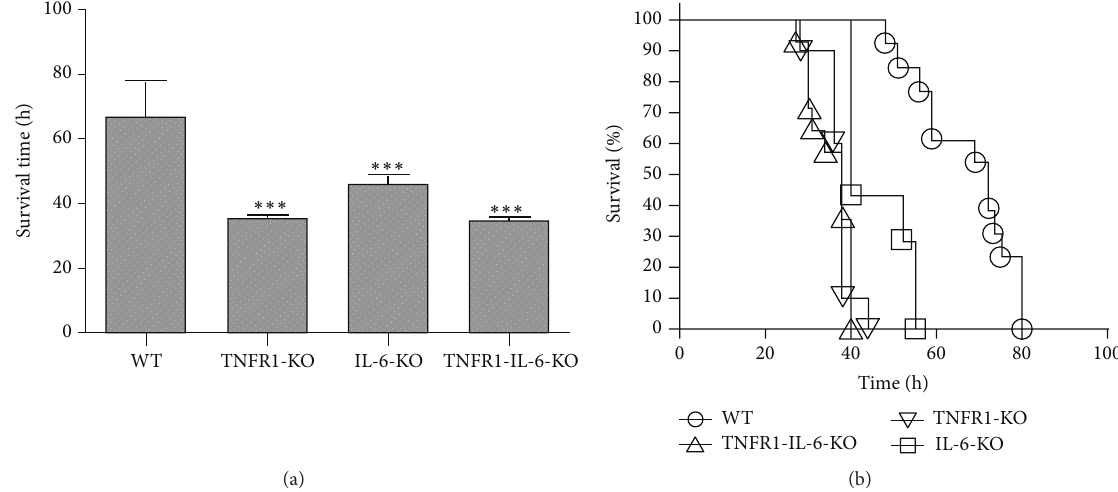
Figure 1: Mortality after pneumococcal meningitis. Wild type (WT), TNFR1-, IL-6, or TNFR1-IL-6 knockout (KO) mice were infected by injection of 10 4 colony-forming units (CFU) of Streptococcus pneumoniae D39 (type 2) strain in the subarachnoid space. (a) Comparison of survival times revealed that WT mice lived significantly longer (WT, 𝑛 = 16 ; TNFR1-KO, 𝑛 = 14 ; IL-6-KO, 𝑛 = 9 ; TNFR1-IL-6-KO, 𝑛 = 18 ; median with percentile; Mann-Whitney 𝑈 test; 𝑝 < 0.0001 for TNFR1- or TNFR1-IL-6-KO versus WT and 𝑝 = 0.0018 for IL-6-KO versus WT). (b) Mortality was significantly increased in TNFR1- and/or IL-6-KO animals (Kaplan-Meier-Curve; 𝑝 < 0.0001 for TNFR1- and TNFR1-IL-6-KO, 𝑝 = 0.0001 for IL-6-KO versus WT; log-rank